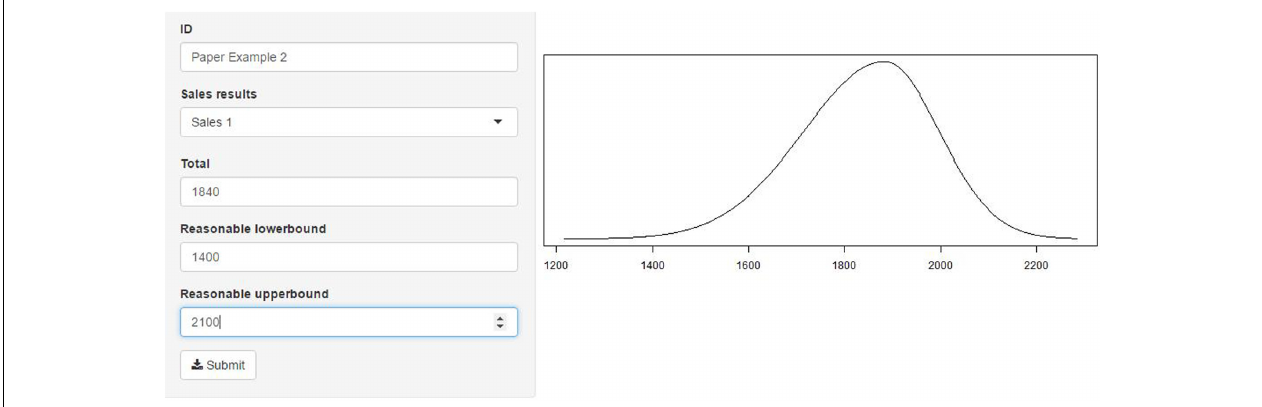
FIGURE 3 | Shiny application for steps 3 and 4. On the left the input fields require entering the estimate for µ 0 and the reasonable lower and upper bound for the estimate. On the right the distribution that is fitted based on the input can be found.